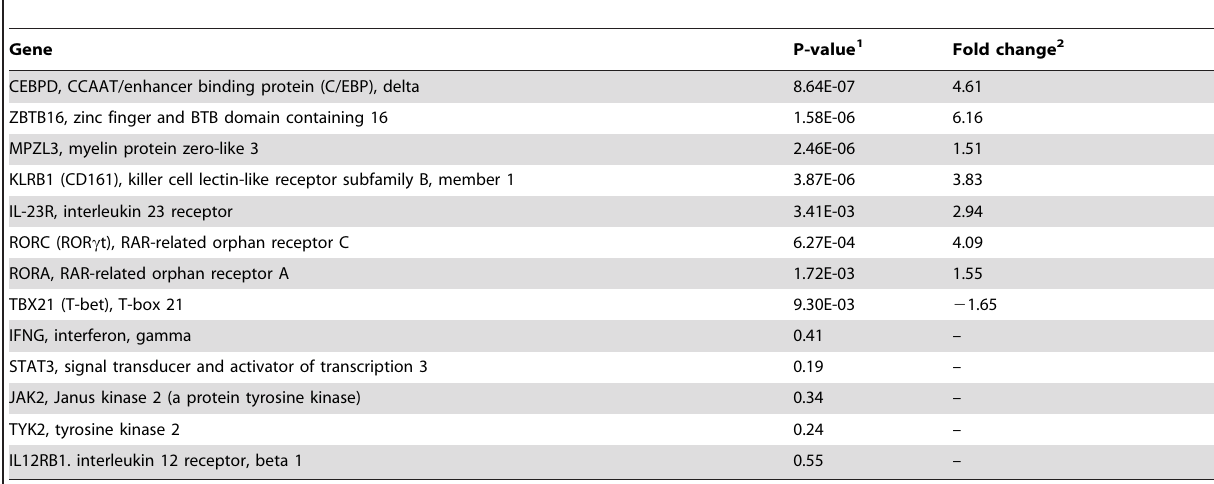
Table 1. Selected results of differential gene expression analysis in CD8 + CD45RO + memory T cells from IL-23-responsive vs. -non- responsive